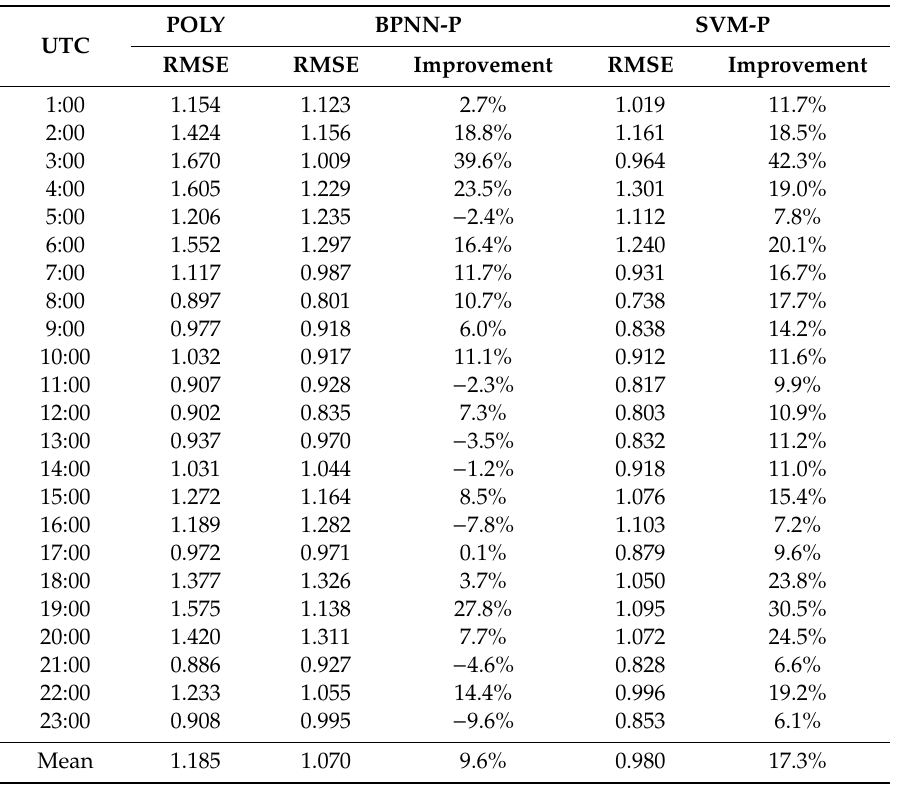
Table 2. Root mean square errors (RMSEs) of three ionosphere models in di ff erent moments